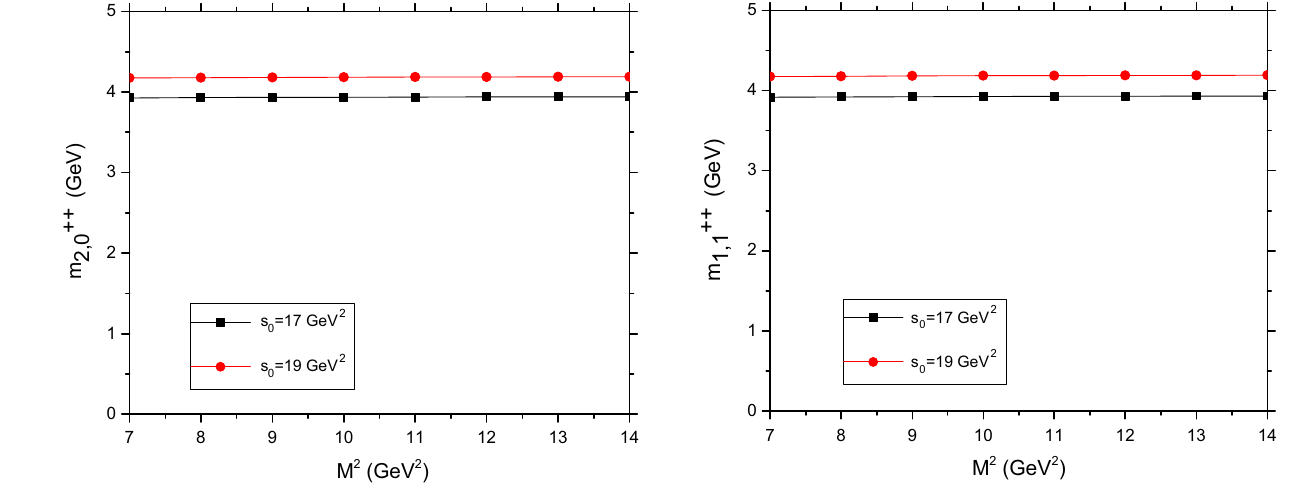
Fig. 5 Borel parameter dependence of J PC = 1 ++ meson mass from (cid:10) ( 1 ) μναβ for different s 0 values